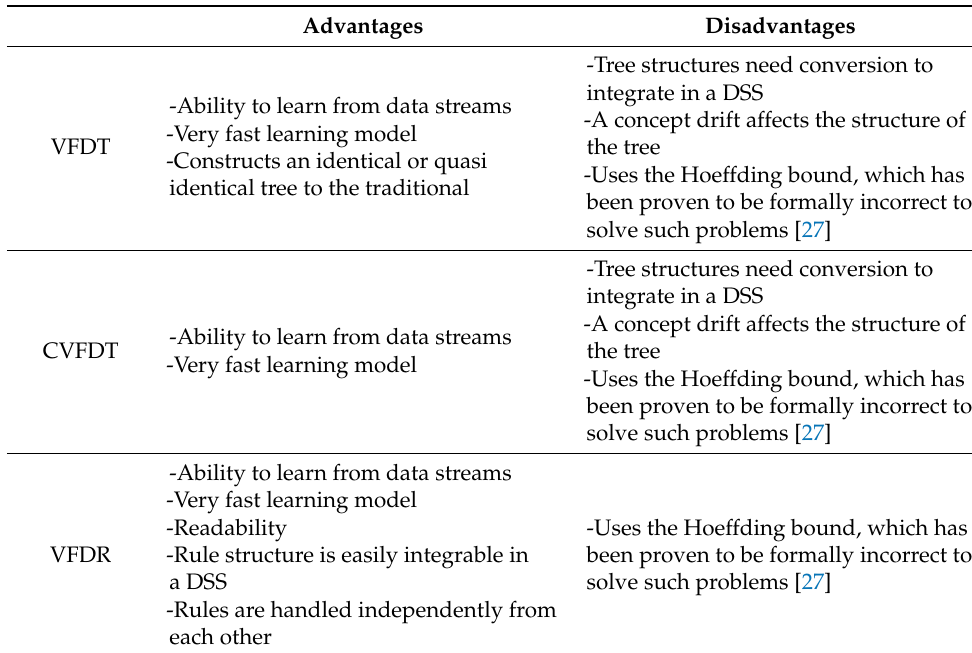
Table 1. Scenarios, noise and mislabeling levels and threshold